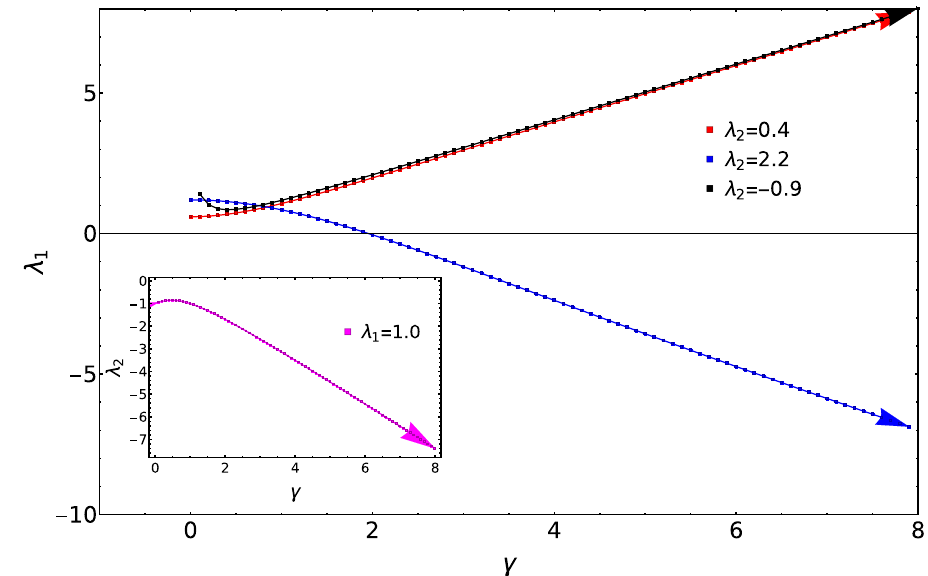
Figure 9. Behavior of critical lines with γ for different values of (cid:31) 1 and (cid:31) 2 . Inset represents the behavior of critical line with (cid:31) 2